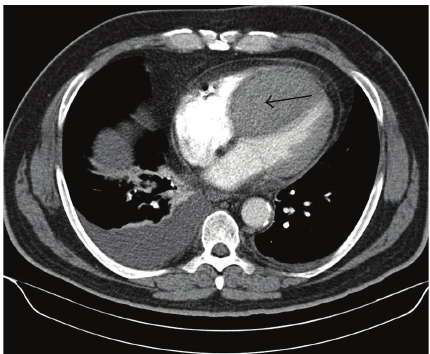
Figure 5: CT scan confirms a huge intraventricular septum-hematoma.